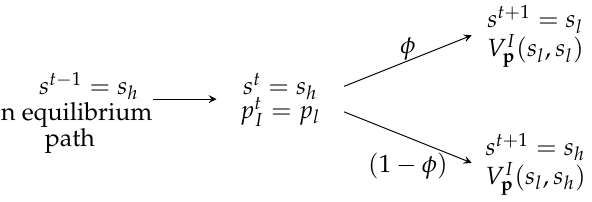
Figure 1. Undetected Deviation. In the cooperative phase of the price leadership profile, the informed firm can cut price without being